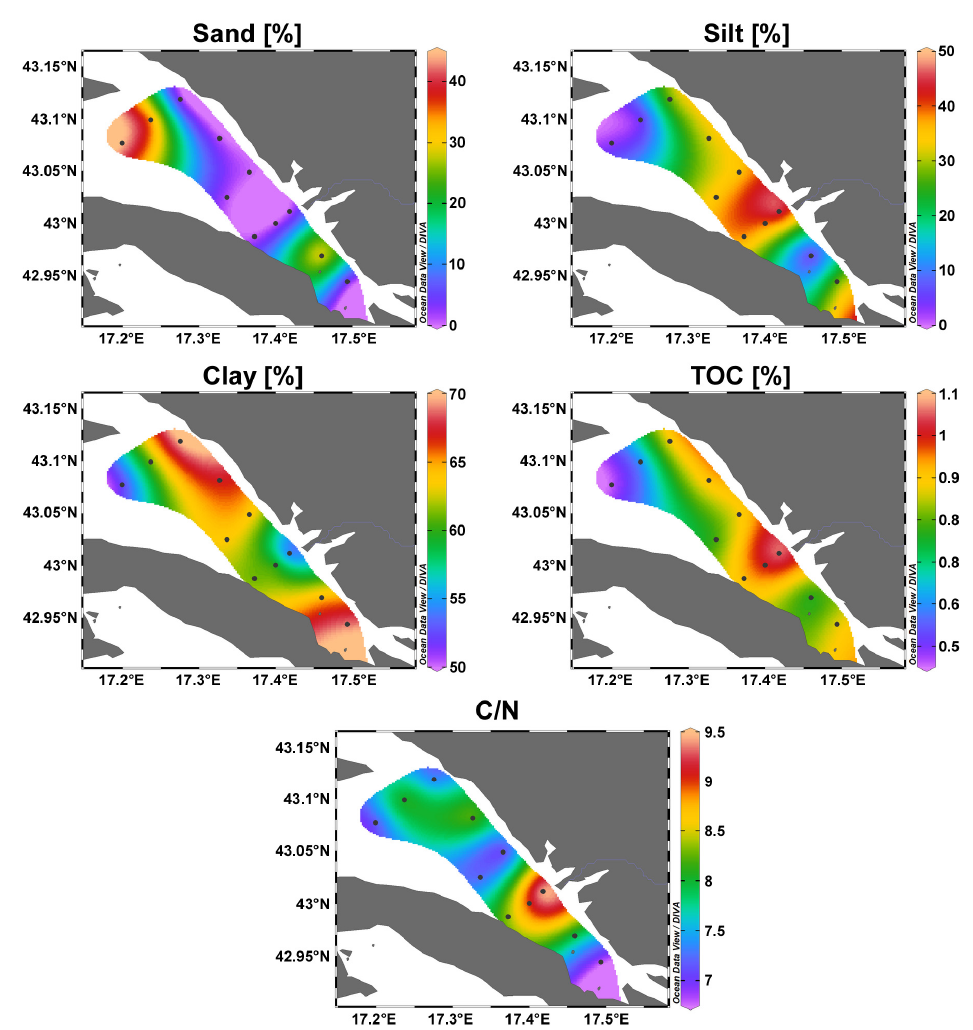
Figure 2. Geochemical and sedimentological composition of surface sediments (grain size, TOC, and C/N). Black dots correspond to study sites; gray and white colors indicate land and sea ares respectively. Modified from [28].